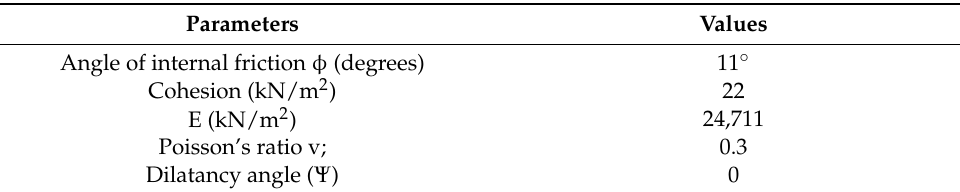
Figure 1. Typical soil profile of study area. Table 1. Soil properties.